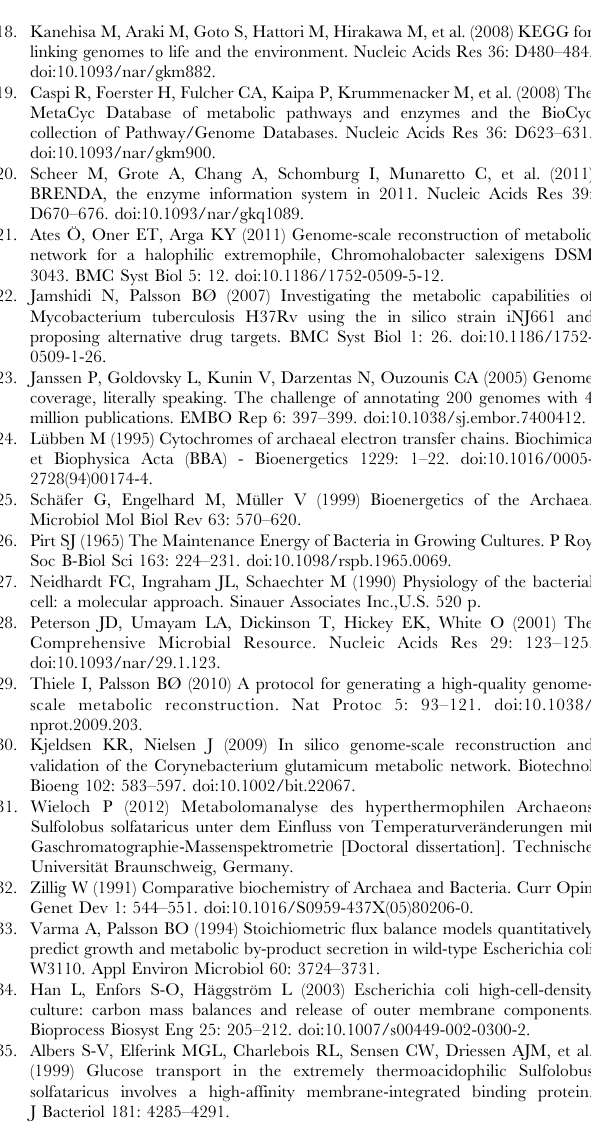
Figure S1 The iterative and automatic model building procedure used to generate iTU515. The genome